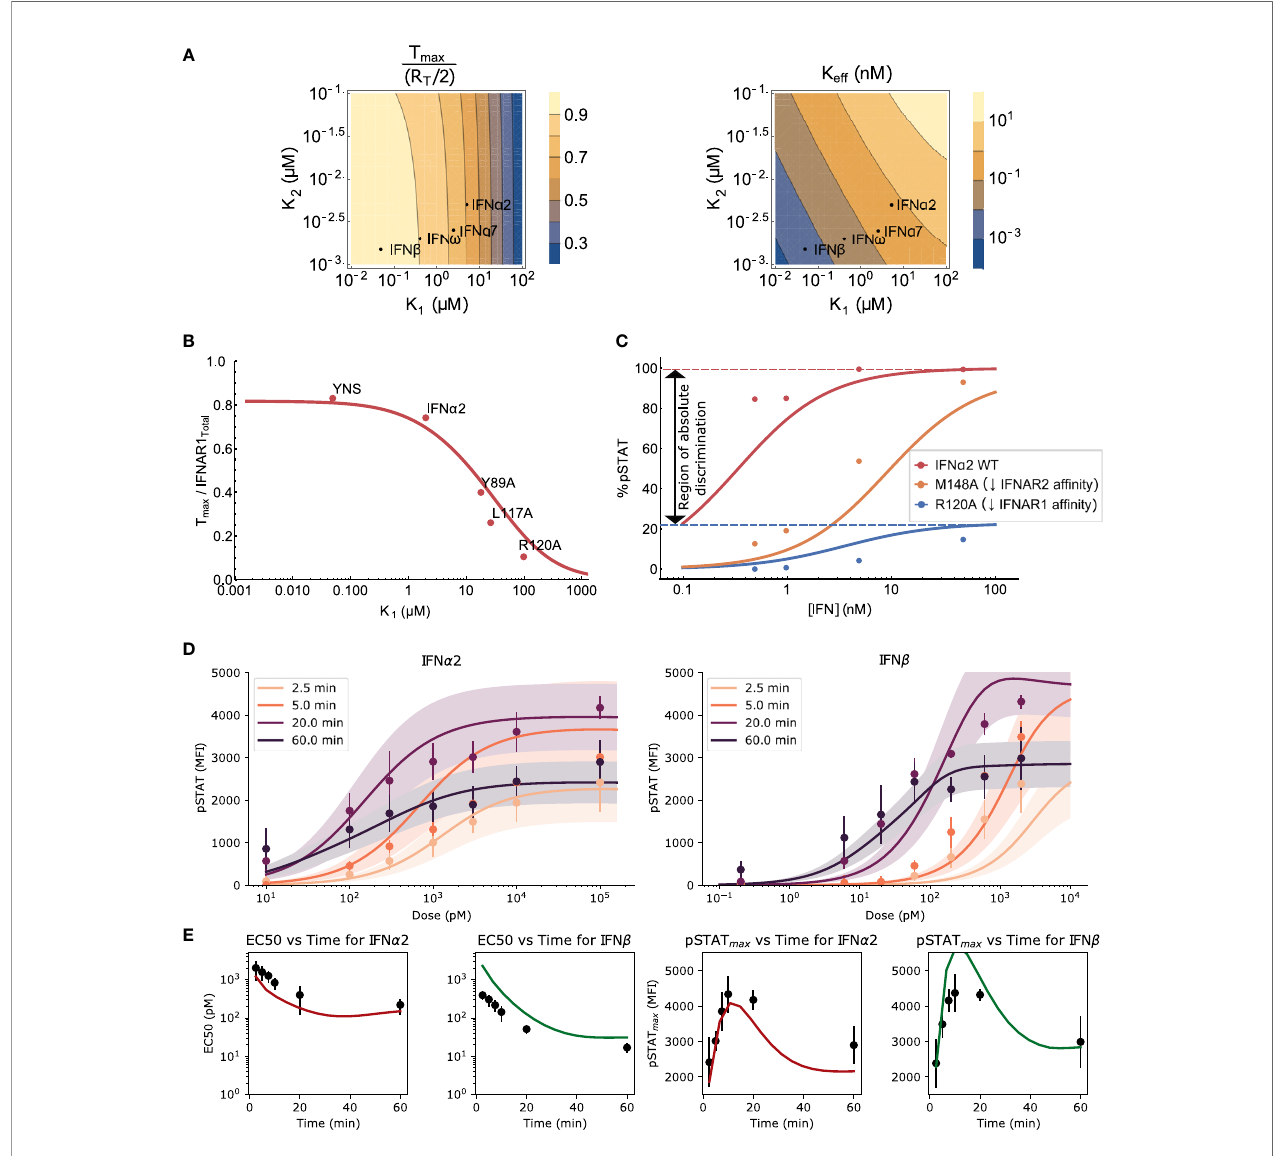
FIGURE 2 | Validation of the model and the effects of ligand af fi nity on response speci fi city. (A) The theoretically predicted values of T max and K eff as functions of binding af fi nities, maintaining detailed balance (see Mathematical Methods ). T max is normalized to be between 0 and 1, with D = 0 in both plots. Both T max and K eff are sensitive to changes in K 1 but only K eff is sensitive to changes in K 2 in the regime of interest. (B) The T max normalized by total IFNAR1 for different IFN a 2 mutants was measured directly in (10). Varying IFNAR1 binding af fi nity in Eq. 1 (red curve) explains observed differences in T max (points). (C) pSTAT1 Western blot band intensities (points) measured in (10) for wild-type (WT) IFN a 2 and the IFN a 2 mutants R120A and M148A. The effect of the mutations on the dose-response curve are recapitulated by the equilibrium model (Eq. 4) using a 60-fold (R120A) and 50-fold (M148A) change in K 1 (and the corresponding change in K 4 ) or K 2 (and K 3 ), respectively. Kinetic parameters ( K p , S T , A ) match those used in the ODE model presented in (D) , and af fi nities from (10). (D) The experimental data from mouse B cells (points with error bars) and simulated (solid lines) dose response curves for IFN a 2 and IFN b at different stimulation durations. Each dose-response curve is the average model prediction with a one standard-deviation envelope, representing 30 samples from the fi tted log-normal distribution of IFNAR1 and IFNAR2 expression. Additional timepoints shown in Figure S2 . (E) The EC 50 (left) and maximal response (right) computed from the data (black points with std. dev. shown) and the model (solid